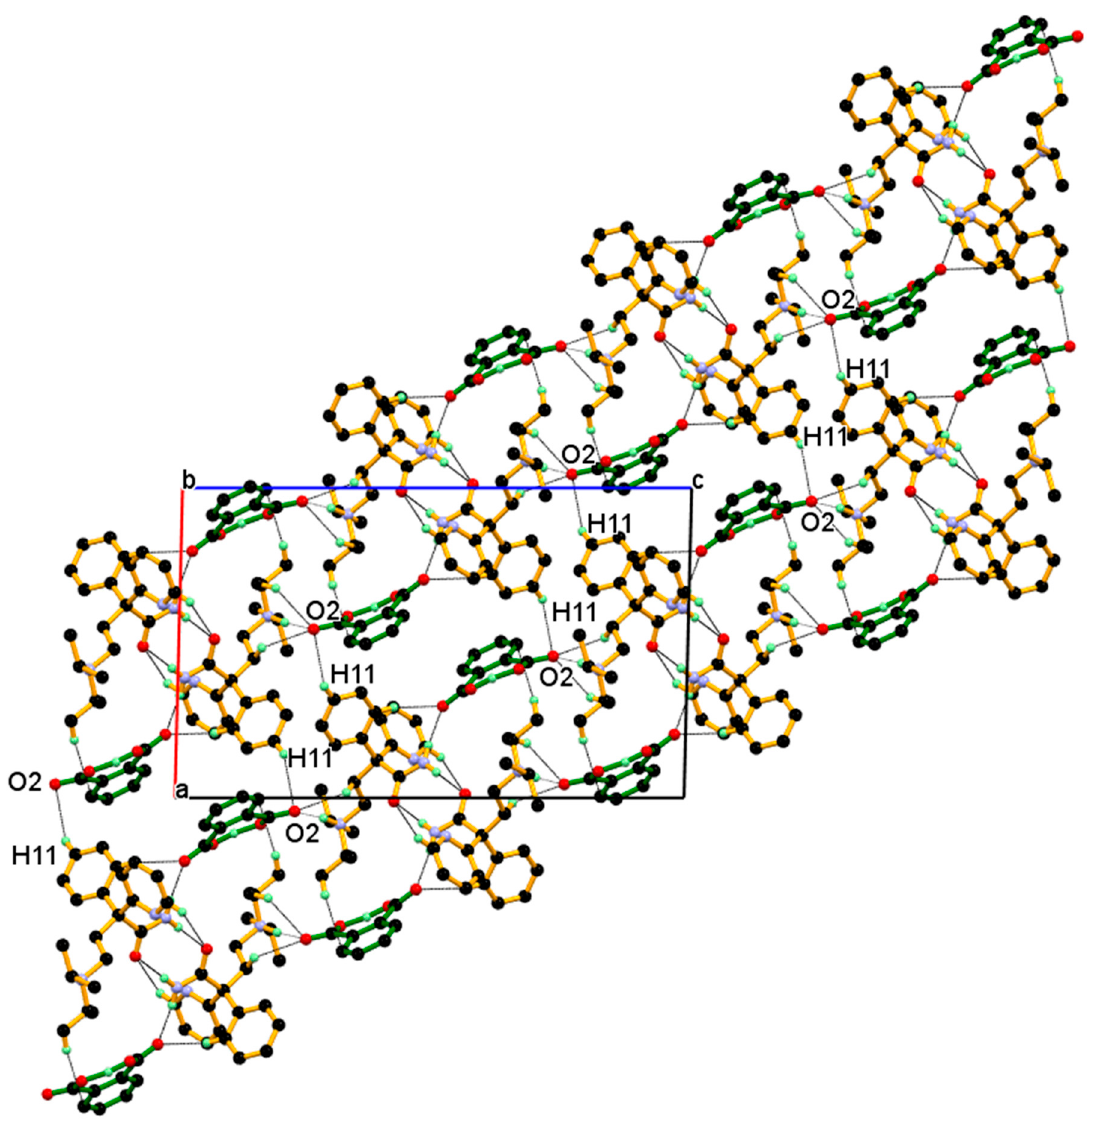
Figure 11. 2-Dimentonal network of dimeric unit assembled centrosymmetric fashion through weak and longer C11- H11 ∙∙∙ O2 ¯ interaction resulting in 3-D packing of dimeric unit in the ac -plane.